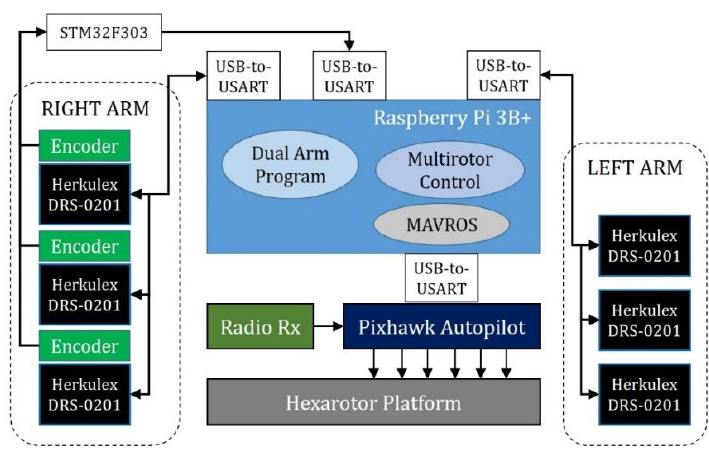
Figure 4 . Hardware architecture of the aerial manipulation robot.